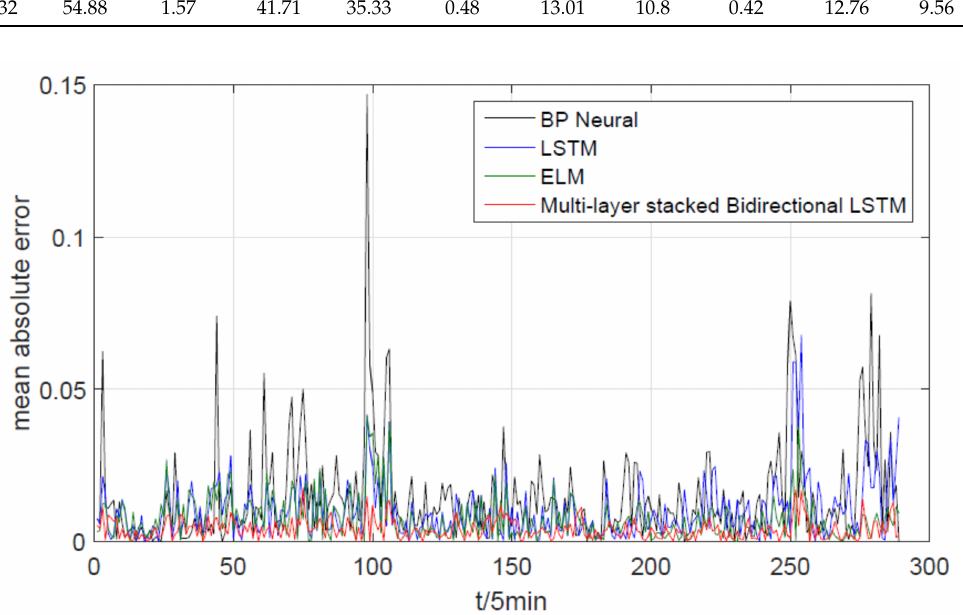
Figure 8. Comparison of different prediction mode. Different samples of training data will significantly affect the robustness of the load forecasting model. The load will be more accurate with a smaller sample in the training dataset. With 48 or 24 measurement points, the training dataset will be more random, which will increase the difficulty of the load prediction. In this paper, a sample dataset with 48 measurement points is used for the training of the proposed method to verify the robustness of the proposed method and compare it with other methods. Figure 9 shows the comparison of the load forecasting results with a half-hour training dataset; the proposed method is accurate enough to track the load profiles based on deep learning, which can extract the internal characteristics of the discrete sample load data and improve the robustness of the proposed method with the multi-layer bidirectional training mechanism. The MAPE of the proposed method is 2.39%, as shown in Table